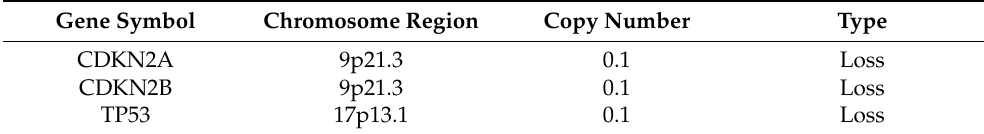
Figure 2. Single-nucleotide polymorphism array analysis. Focal copy number alterations were identified in NCC-MFS5-C1 cells. The X - and Y -axes indicate chromosomal location and the log ratio of copy number alterations, respectively. Table 2. Representative copy number alterations.